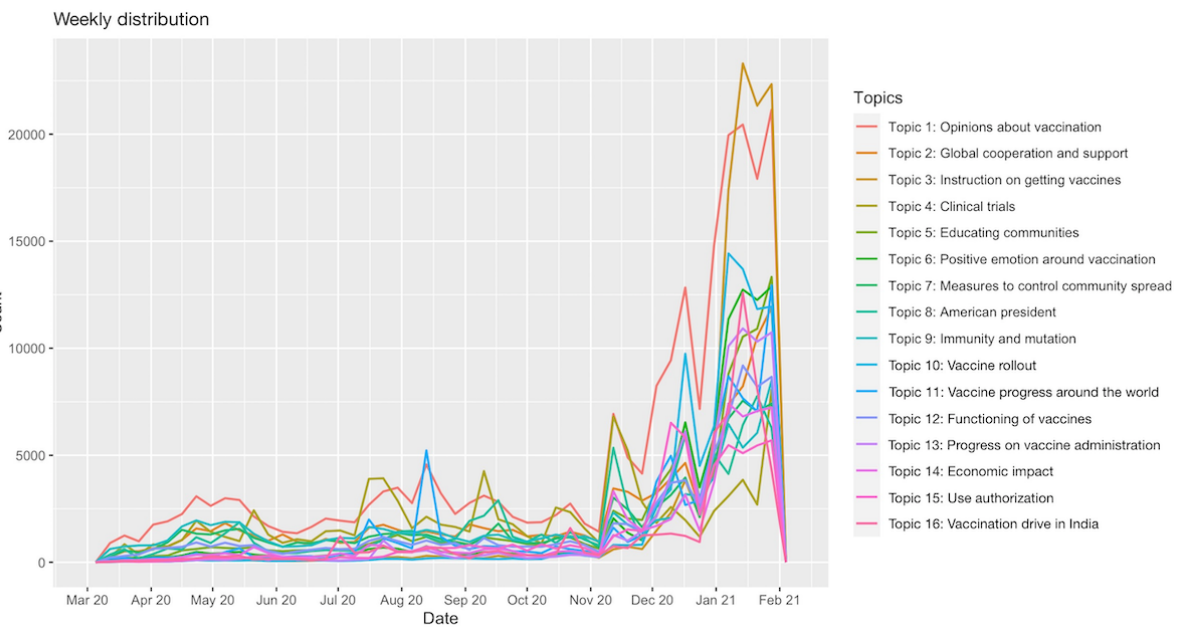
Figure 2. Weekly frequency of each topic on Twitter from March 11, 2020, to January 31,